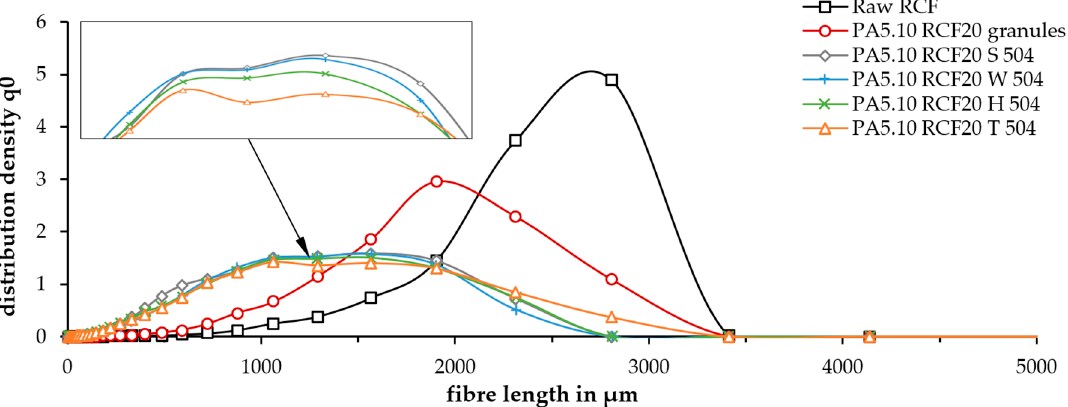
Figure 4. Fiber length distribution of raw RCF, compounded PA5.10 RCF granules, and parts of the accelerated-aged test specimen (taken from the parallel section). Table 4. Mean values of the fiber lengths of all